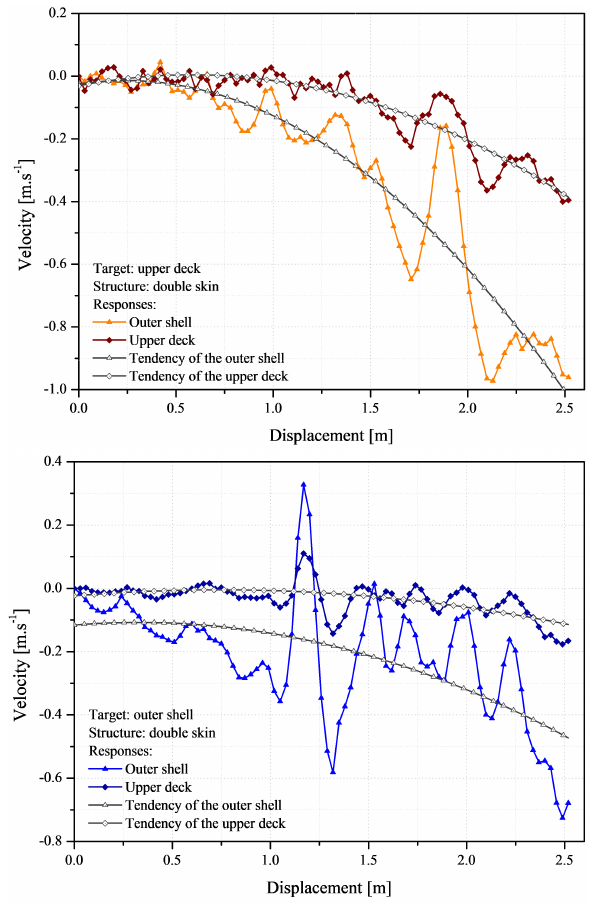
Figure 12: Velocity of the targets on double side skin [DSS] during side